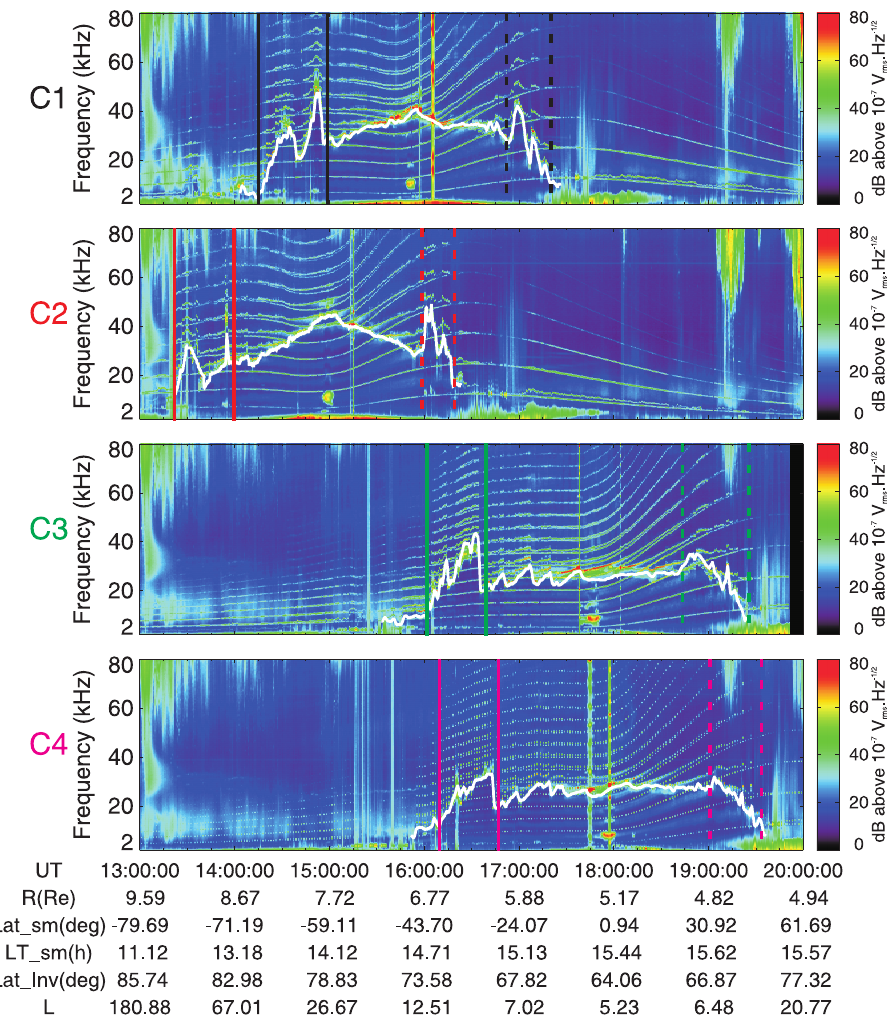
Fig. 1. Frequency-time electric field spectrograms measured on 18 July 2005 by the WHISPER instruments onboard the four Cluster spacecraft. The entire plasmasphere pass is shown, including a plume during the inbound and outbound parts of the pass. The white lines trace the electron plasma frequency F pe . The orbital parameters correspond to C4. The colored lines delimit the plume crossings for each satellite, with full lines for the Southern Hemisphere one and dotted lines for the Northern Hemisphere